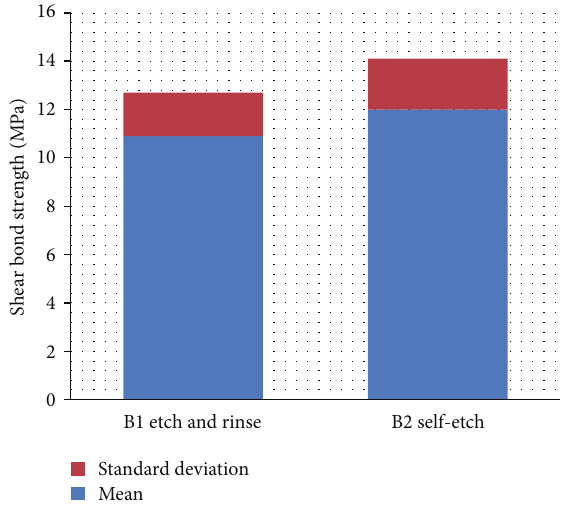
Figure 4: The effect of the adhesive system on the shear bond strength values.